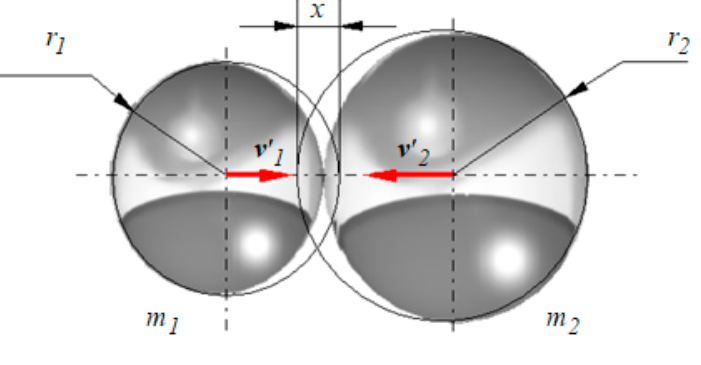
Figure 1. Impact